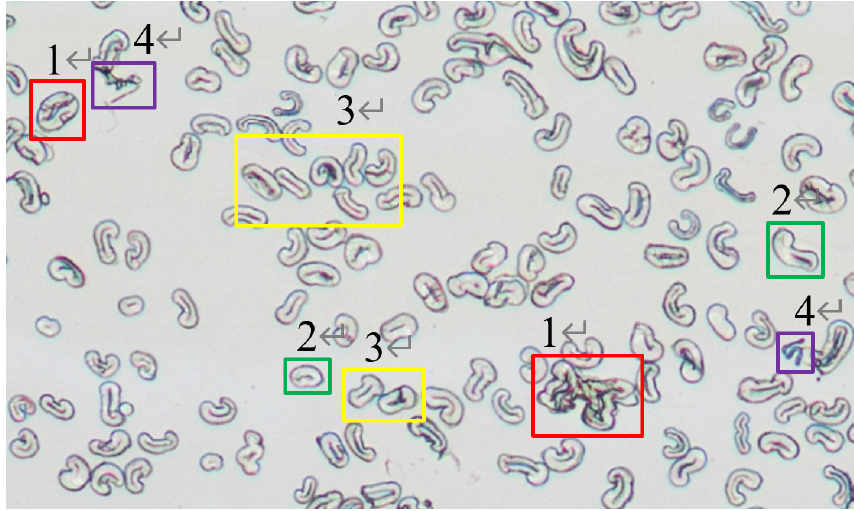
Figure 1. Microscopic image of cotton fiber cross-section